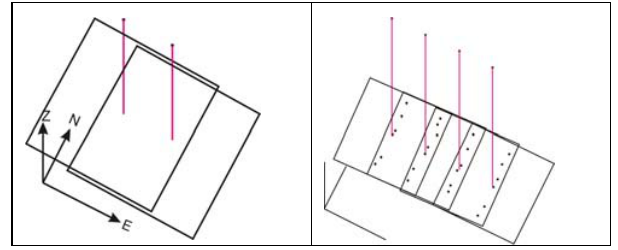
Figure 1: Left: configuration of aerial images with 63cm GSD Right: configuration of aerial images with 7cm